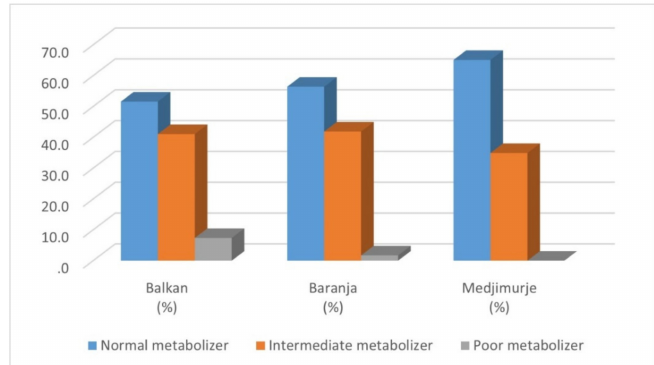
Figure 5. Distribution of estimated phenotype categories in three Roma